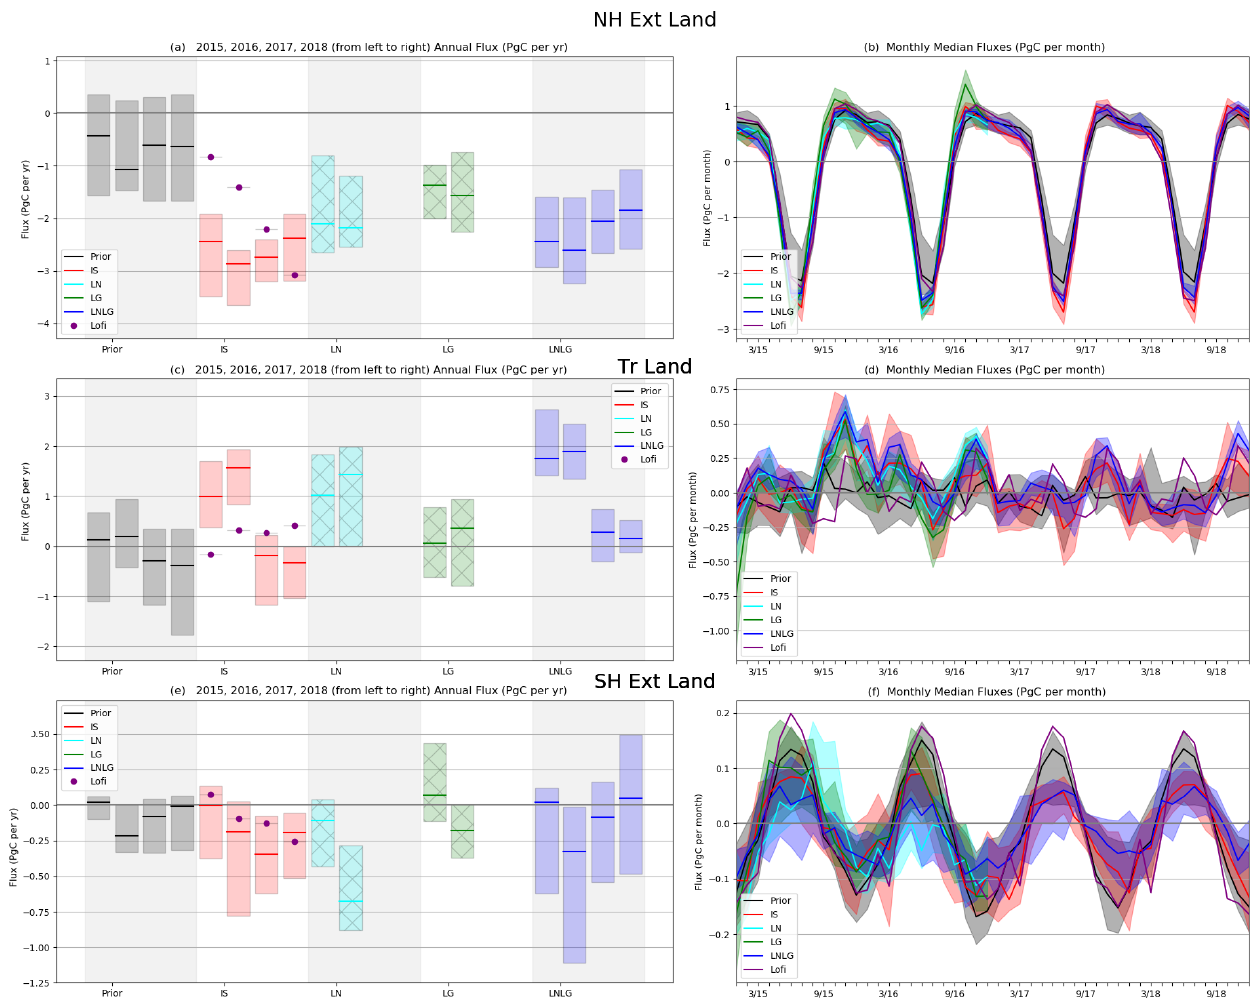
Figure 7. Same as Fig. 6 but for the zonal band: northern extra-tropics (NHExt, a, b ) with latitudes from 23–90 ◦ N, tropics (c, d) with latitude from 23 ◦ S–23 ◦ N, and southern extra-tropics (SHExt; e, f ) with latitude from 90–23 ◦